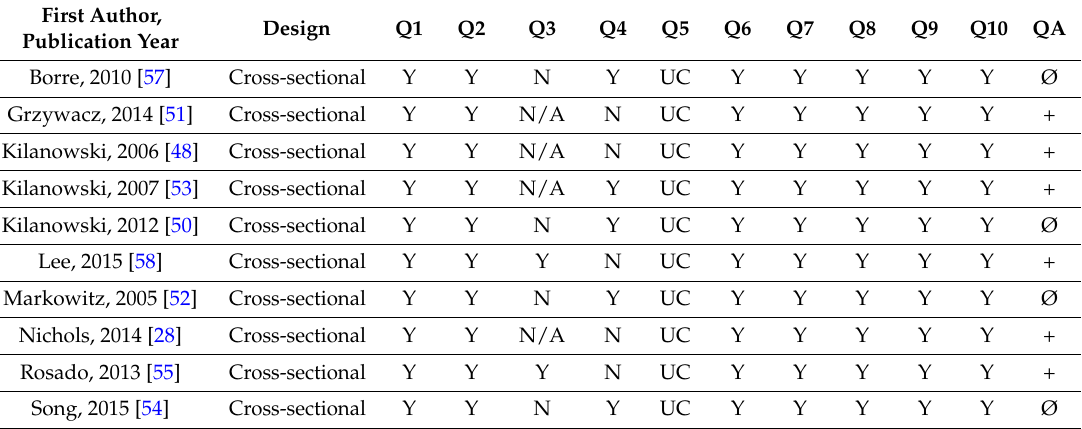
Table 3. Qualitative assessment of studies included in the systematic review 1